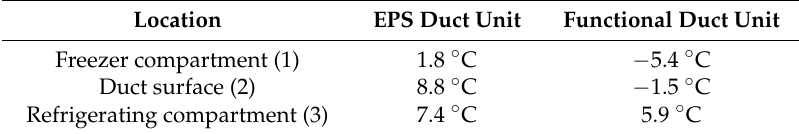
Table 4. Summary of temperature measured at pre-selected locations at T pe .